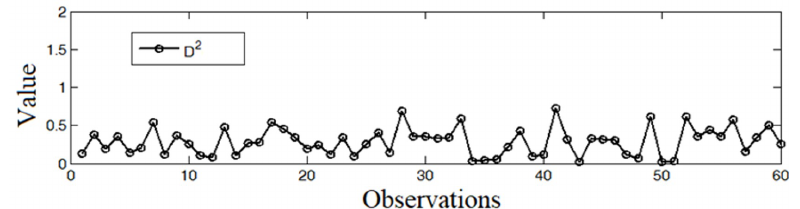
Figure 5. Vector of Mahalanobis distance between C and ( C , S X ) of X